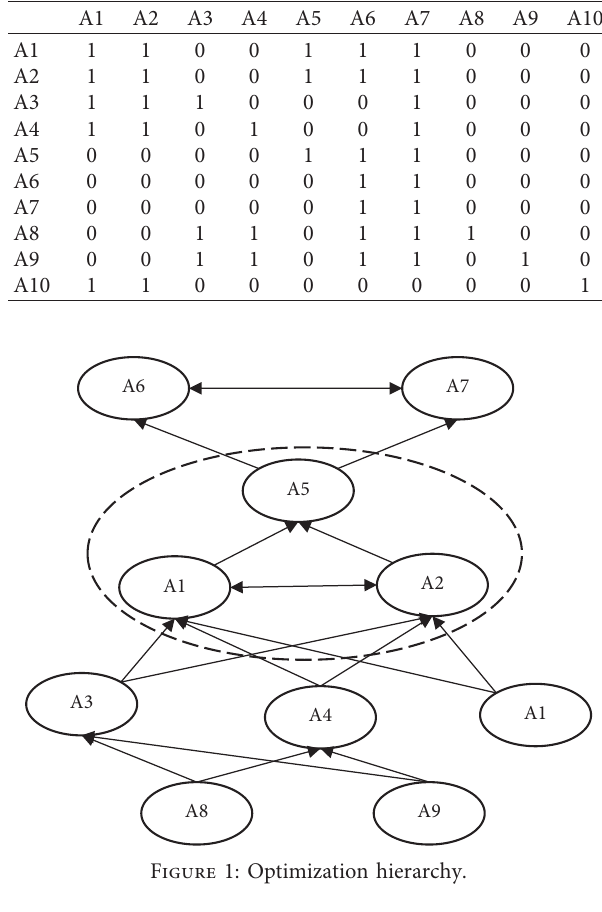
Figure 1: Optimization